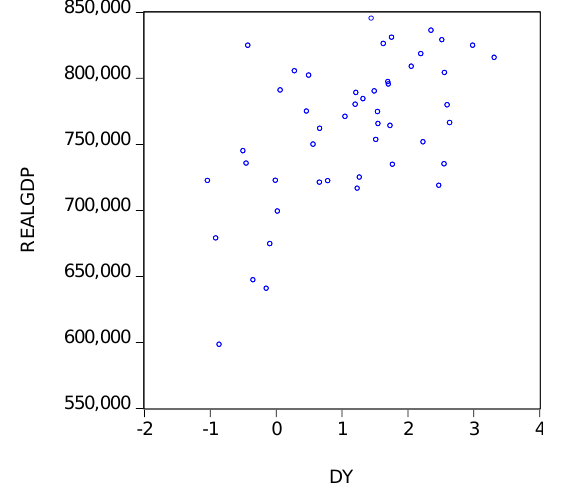
Figure 2: Scatter Diagram between Serbia’s Real GDP (REALGDP) and the Deficit-to-GDP